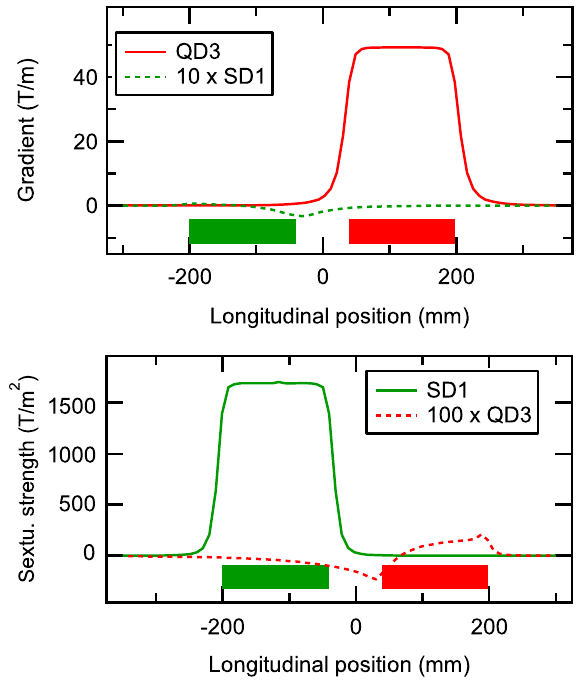
FIG. 8. Longitudinal distribution of the spurious gradient and sextupole strength 1 = 2 d 2 B z =dx 2 for a SD1 sextupole (powered at 60 A) placed at 75 mm from a QD3 quadrupole (powered at 80 A). Top: gradient from the quadrupole and gradient error from the sextupole (magnified by a factor of 10). Bottom: sextupole strength from the sextupole and error from the quadrupole (magnified by a factor of 100).